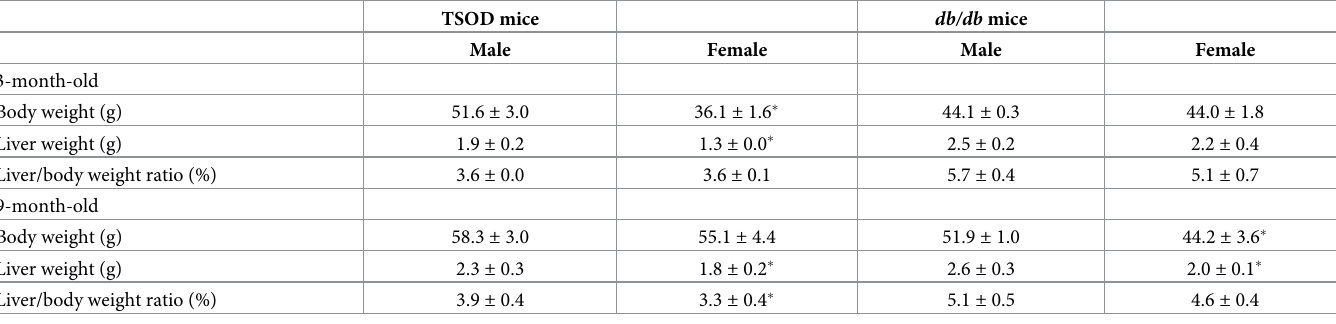
Table 2. Body and liver weights of the